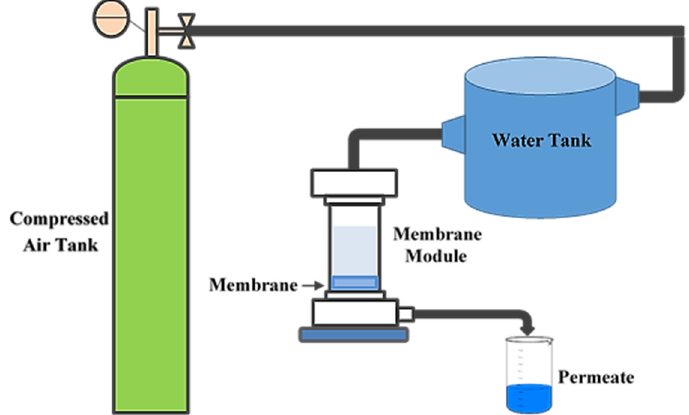
Figure 4. MF experimental setup.